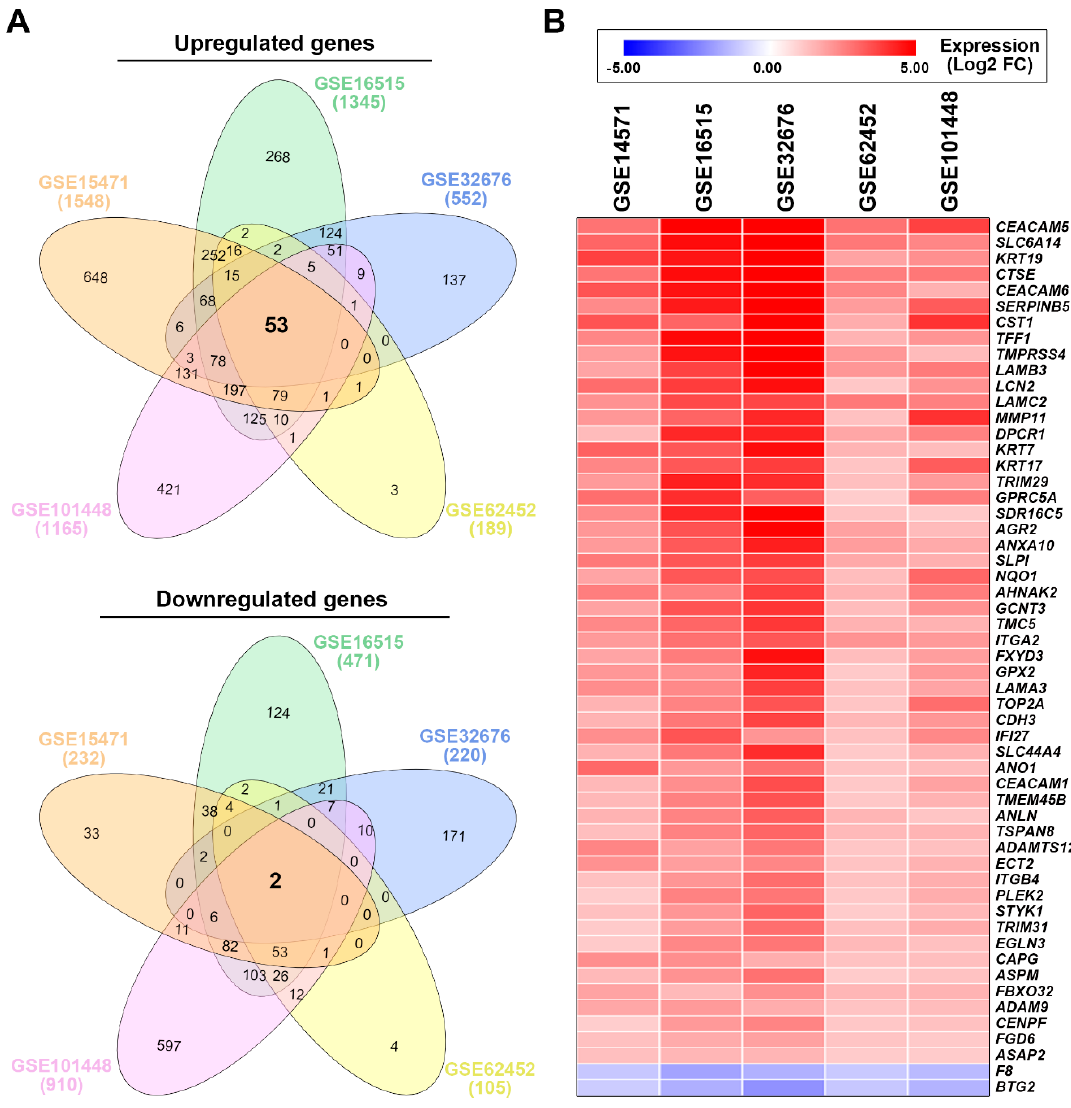
Figure 1. The common gene signature in human pancreatic ductal adenocarcinoma. ( A ) The Venn diagrams show the overlapped gene numbers among five microarray data sets. ( B ) The heat map shows the relative expression for the common gene signature.